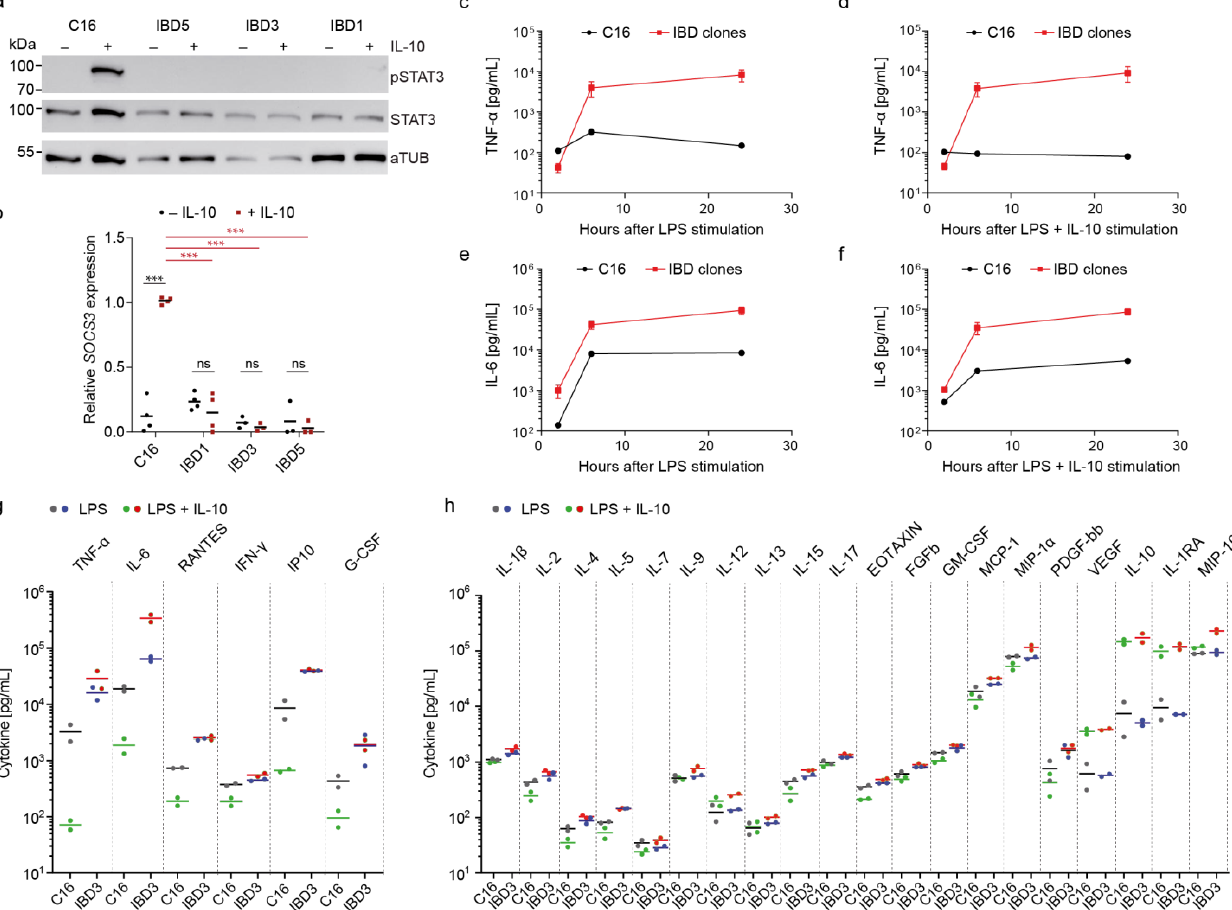
Figure 3. Deficient immune regulation in VEO-IBD iPSC-derived macrophages. ( a ) Detection of STAT3 phosphorylation (pY705; pSTAT3) upon LPS stimulation in iPSC-derived macrophages. Expression of STAT3 and alpha-Tubulin (aTUB) as controls. ( b ) Detection of IL-10-induced SOCS3 mRNA expression in healthy and IBD-iPSC-derived macrophages by qRT-PCR (mean of biological replicates, n = 3; *** p ≤ 0.001 two way-ANOVA and Holm–Šídák multiple comparison test). ( c ) Screening of TNF-α secretion by LPS-stimulated iPSC-derived macrophages over time using Bio-Plex assay (mean ± SD of IBD clones; n = 3). ( d ) Secretion of TNF-α upon LPS and IL-10 co-stimulation of macrophages over time (mean ± SD of IBD clones; n = 3). ( e , f ) Detection of IL-6 secretion by LPS, or LPS and IL-10 stimulated iPSC-derived macrophages (mean ± SD of IBD clones; n = 3). ( g ) Bio-Plex-based detection of IL-10 regulated inflammatory cytokines 6 h after LPS, or LPS and IL-10 co-stimulation of iPSC derived macrophages (biological replicates, n = 2). ( h ) Moderate or no effect of IL-10 on LPS-stimulated cytokine secretion as detected by Bio-Plex analysis (biological replicates, n = 2).